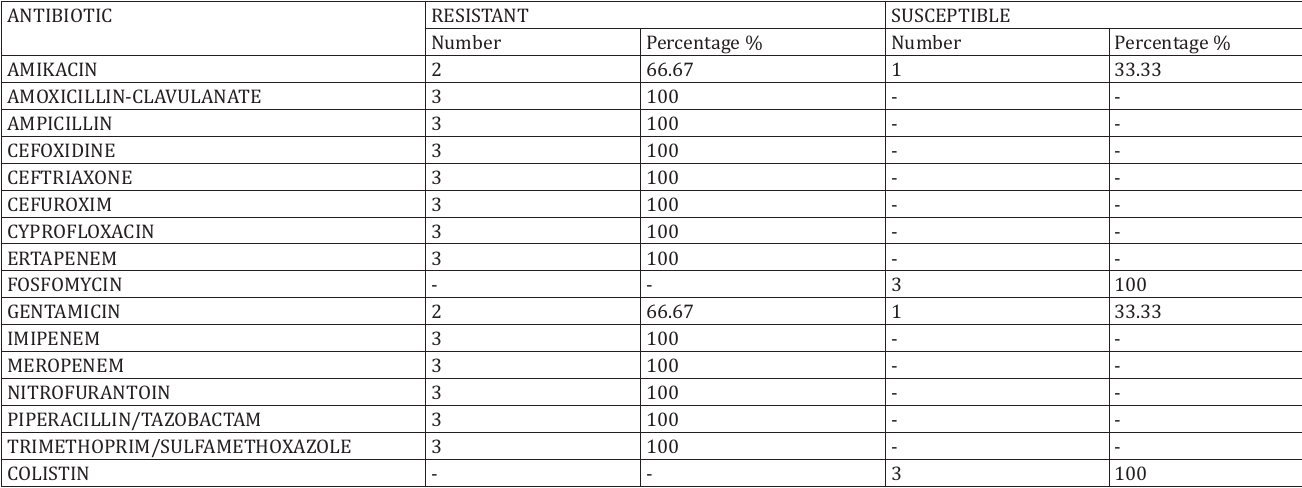
Antibiotic susceptibility test result of E. coli isolates